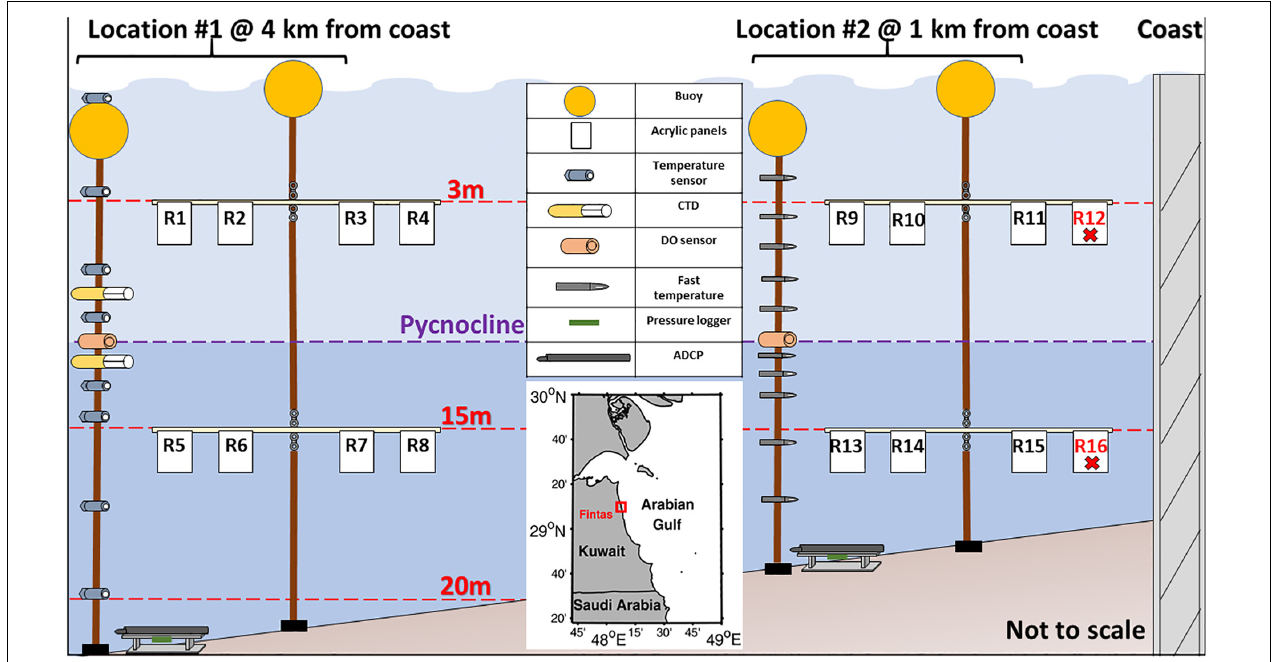
FIGURE 1 | Map and schematic of the sampling design at locations #1 and #2 off the coast of Fintas, Kuwait.